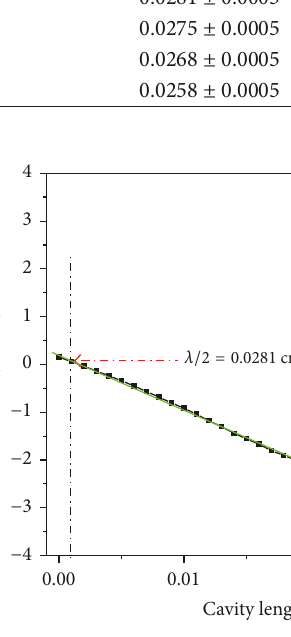
Figure 8: Typical behavior of the phase of PE signal as a function of cavity length for Ag nanofluid (S1) at 6.73 Hz.